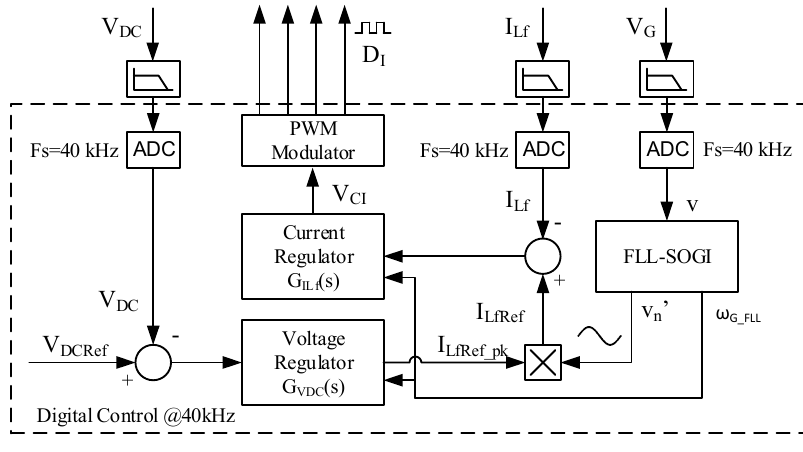
Figure 2. VSI control scheme.